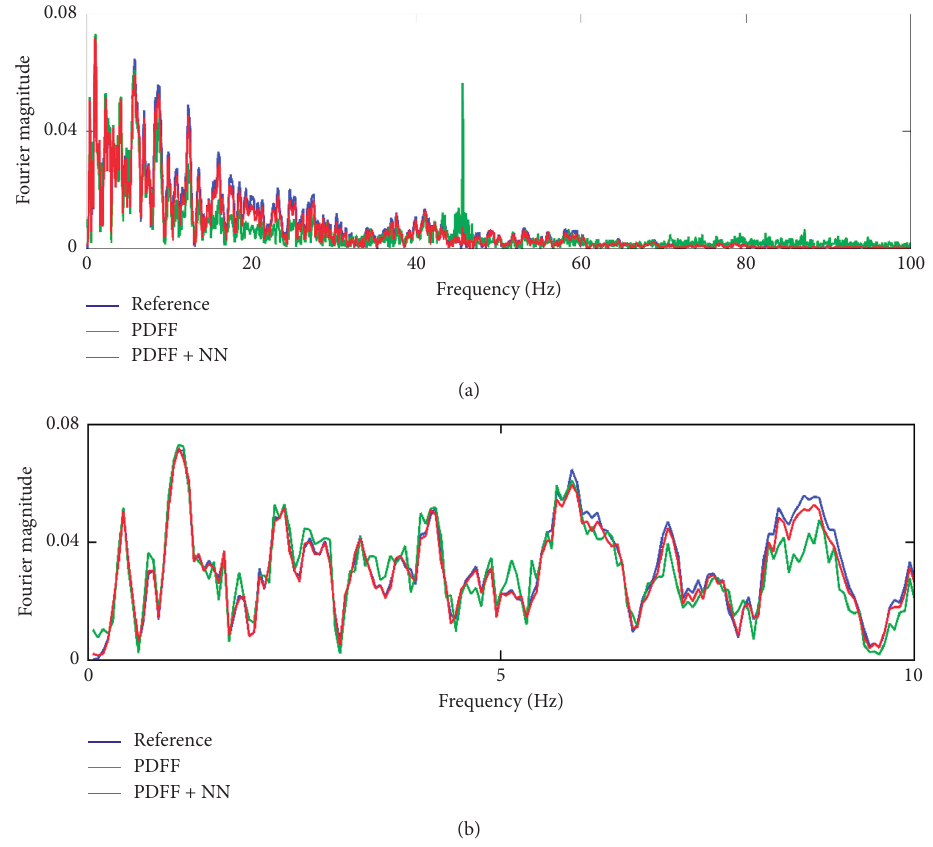
Figure 11: FFT comparison between the measured and the desired signal for the El Centro earthquake record (unloaded table). Table 6: RMSE relative error values for different earthquake records in time and frequency domain analysis (unloaded table). Ground motion